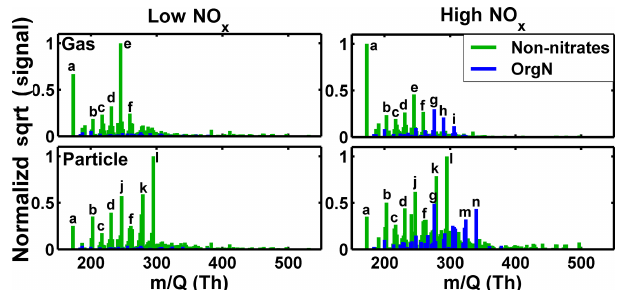
Figure 2. Mass spectra for compounds with the compositions C x H y O z I − (green) and C x H y NO z I − (blue) at low- (left) and high- (right) NO input in both the gas (top) and particle (bottom) phases. Bars are sized by the square root of signal (countss − 1 for the gas phase, counts for the particle phase) to show the dynamic range. Major components are labeled with letters corresponding to those found in Table